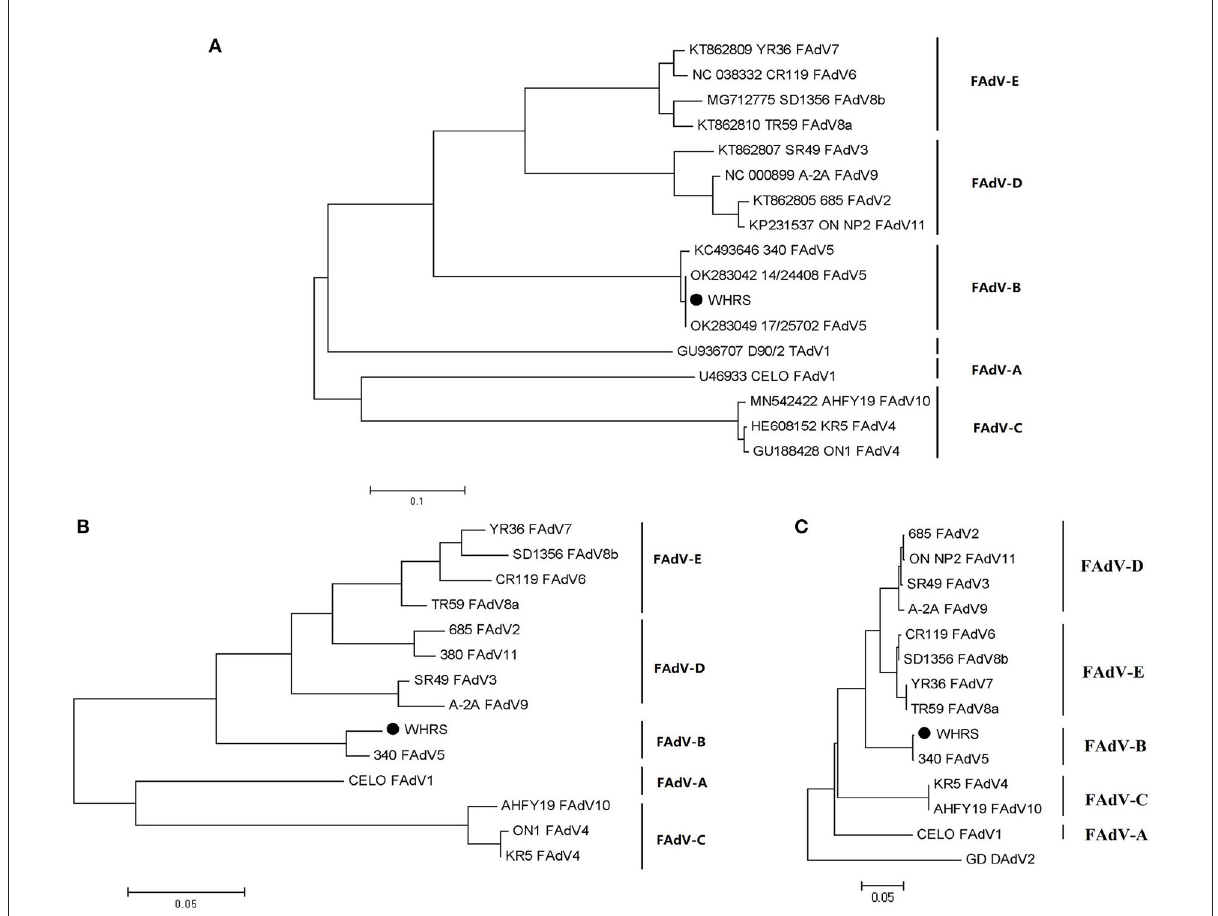
FIGURE3 (A) Phylogenetic tree constructed using the ML method based on the genomic sequences of the WHRS strain (•) and reference FAdV strains. (B) Phylogenetic tree constructed using the NJ method based on the amino acid sequences of hexon proteins of the WHRS strain (•) and other FAdV strains. (C) Phylogenetic tree constructed using the NJ method based on the amino acid sequences of the penton proteins of the WHRS strain (•) and other FAdV strains.